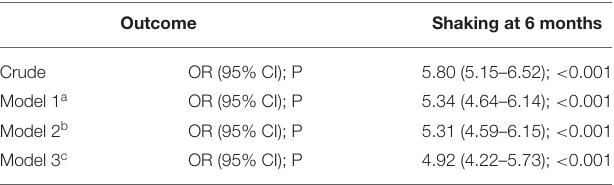
TABLE 4 | Association between shaking at 1 month postpartum and shaking at 6 months postpartum: odds ratios and 95% confidence intervals.